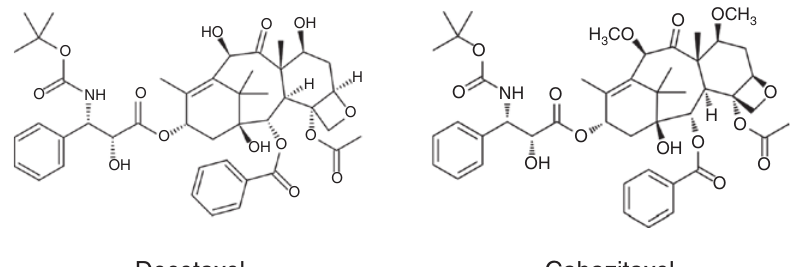
Figure 2: Chemical structure of docetaxel and cabazitaxel.